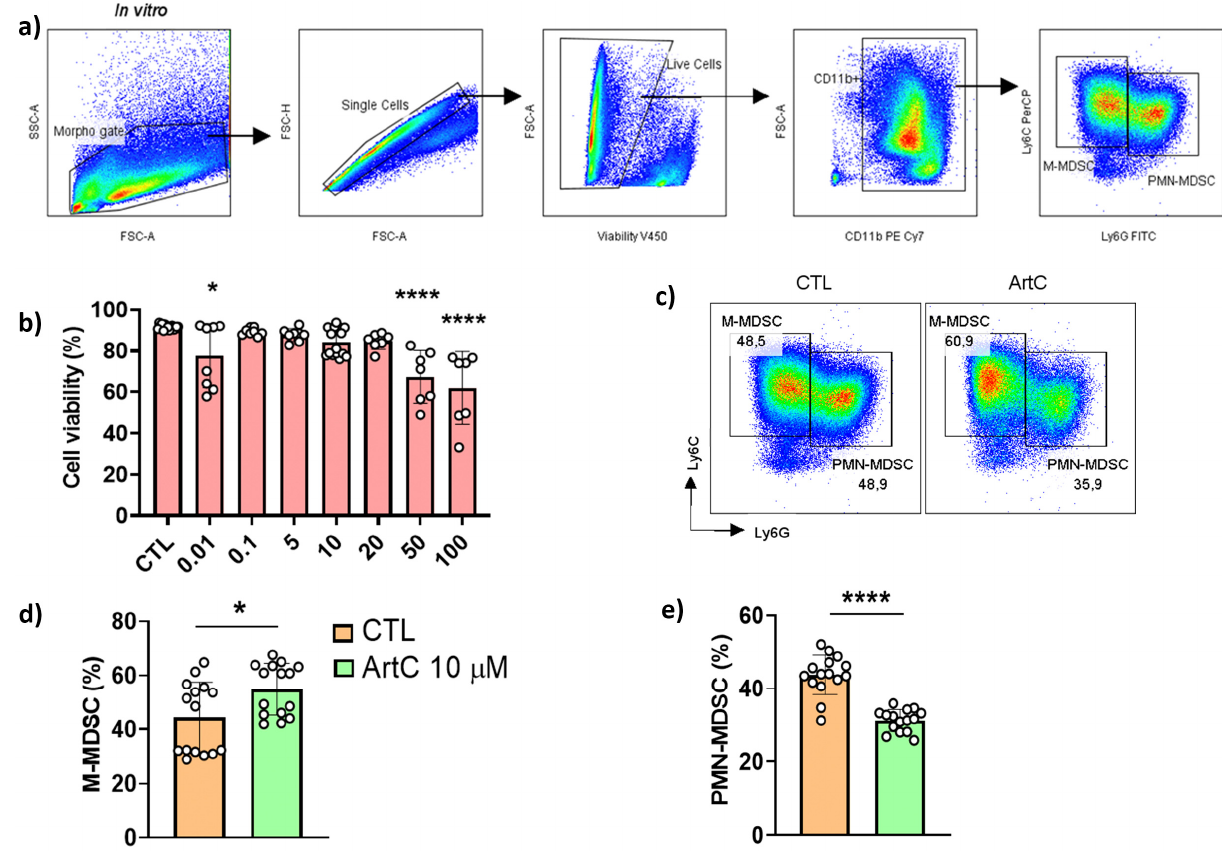
Figure 4. ArtC induces M-MDSC differentiation in vitro. ( a ) Gate strategy for M- (Ly6G − Ly6C + ) and PMN-MDSC (Ly6G + Ly6C int ) characterization in vitro; ( b ) frequency of live cells (FVS780 − ) in culture of bone marrow cells stimulated with rIL-6, GM-CSF and ArtC versus control (CTL); ( c ) representative dot plot of M- and PMN-MDSC generated in vitro in the presence of ArtC (10 µM); ( d ) percentage of M-MDSC, and ( e ) PMN-MDSC. Data are representative of four independent experiments (n = 3–4/group/experiment) and expressed by mean ± SD. * p < 0.05 and **** p < 0.0001.